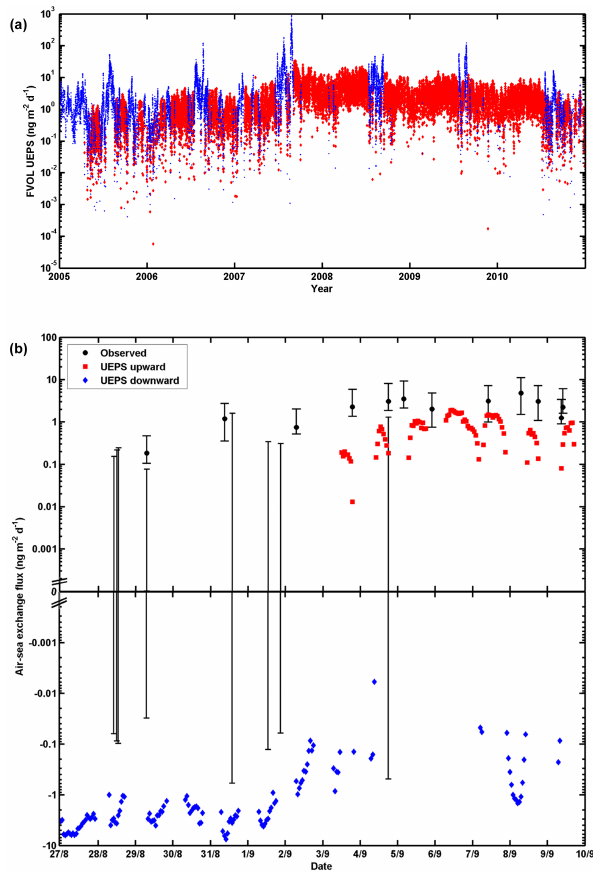
Figure 3. Diffusive air–sea exchange flux, F aw , of RET (ngm − 2 d − 1 ; downward in blue and upward in red) using the up- per estimate parameter set (UEPS) for the eastern Mediterranean (28–45 ◦ N/8–30 ◦ E) (a) model predicted for 1 January 2005–31 De- cember 2010 and (b) model predicted and observed (black) for 27 Author–9 September 2010. Hourly mean data filtered against off- shore winds (see text). Error bars including both signs of F aw reflect C w